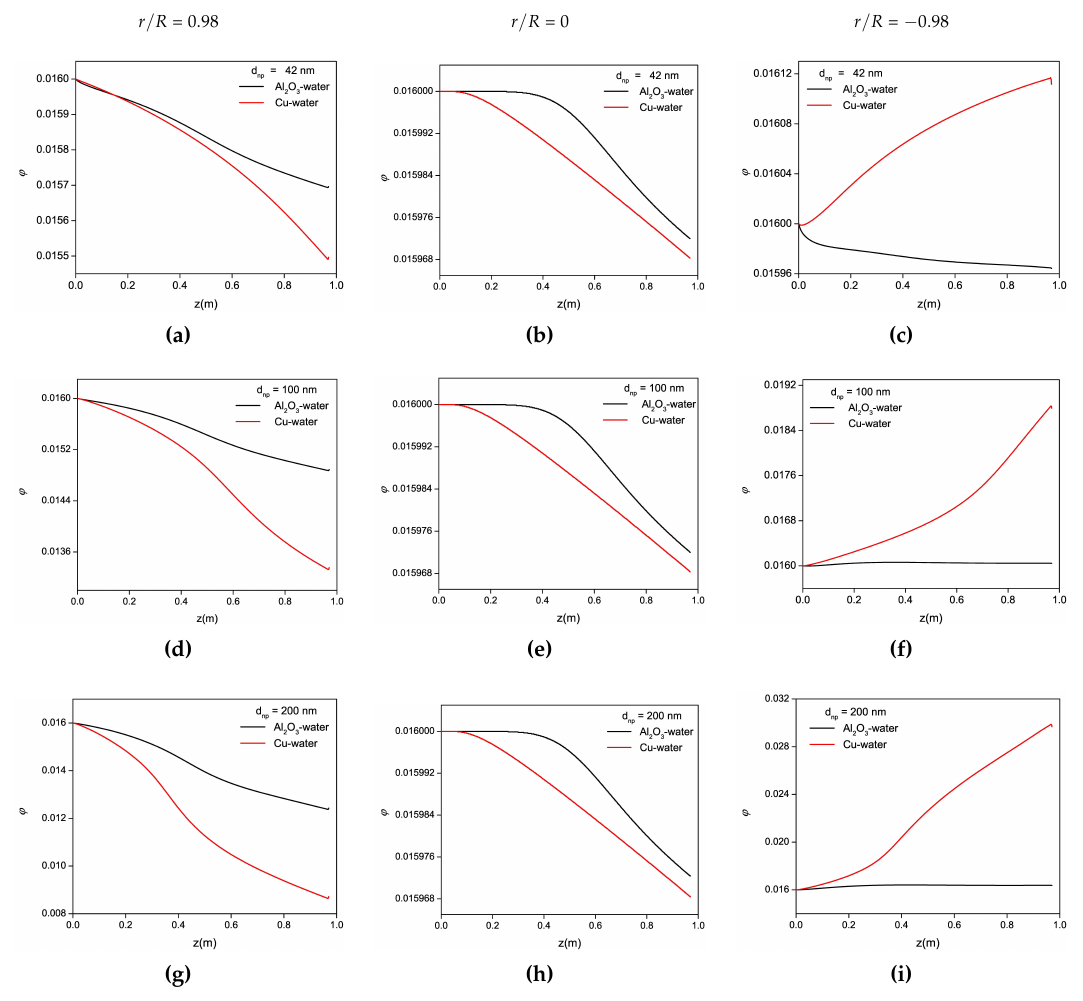
Figure 12. Axial variations of the volume fraction ϕ at three radial locations: r / R = 0.98 ( a , d , g ); r / R = 0 ( b , e , h ); and r / R = − 0.98 ( c , f , i ). Results obtained for Cu and Al 2 O 3 nanoparticles of three different diameters d np = 42 nm ( a – c ); 100 nm ( d – f ); and 200 nm ( g – i ) with ϕ = 0.016 and Re =